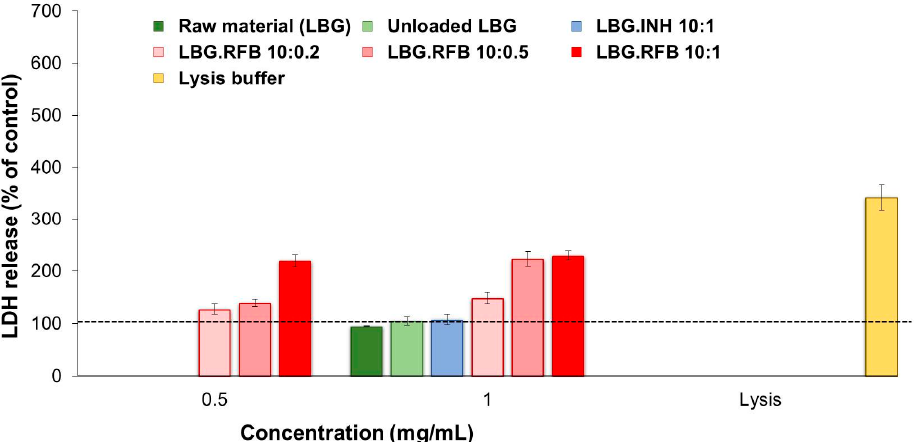
Figure 9. LDH released from macrophage-differentiated THP-1 cells after 24 h exposure to LBG polymer, LBG microparticles and lysis buffer. Amount of LDH released from cells incubated with cell culture medium is assumed as 100% (dashed line). Results are expressed as mean ± SEM ( n = 3, six replicates per experiment at each concentration; INH: isoniazid; LBG: locust bean gum. RFB: rifabutin).